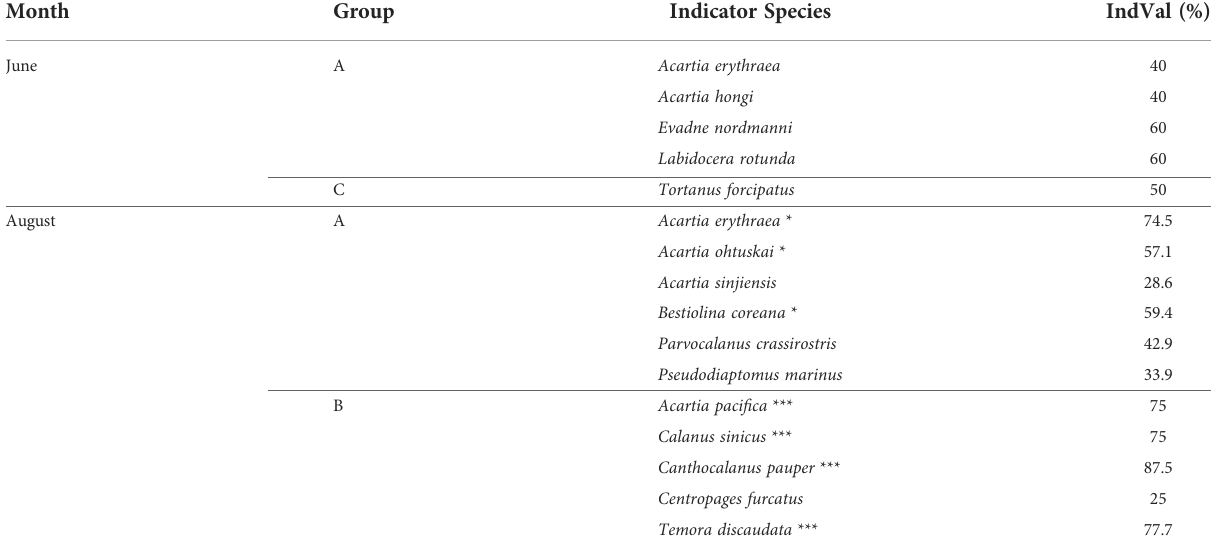
Month Group Indicator Species IndVal (%)